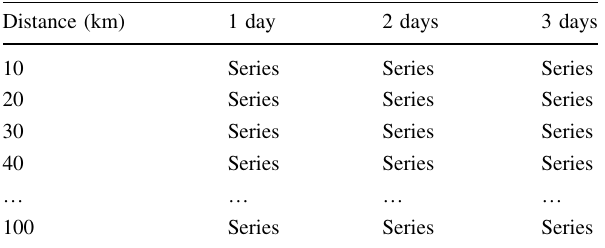
Fig. 7 Establishing the degree of spatial clustering of disasters. Restricted by 0.1 km, the proportion in series is 20%; restricted by 0.2 km, the proportion is 60%; restricted by 0.3 km, the proportion is 83.33%; restricted by 0.4 km, the proportion is Table 1 Time and space threshold restrictions imposed on cluster series